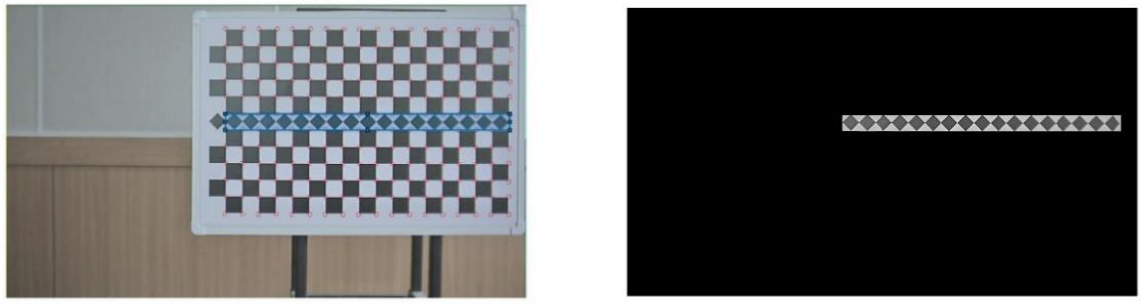
Figure 17. ROI (Region of Interest) of the area where diamonds exist ( left ), Image segmentation to extract diamond vertices ( right ).